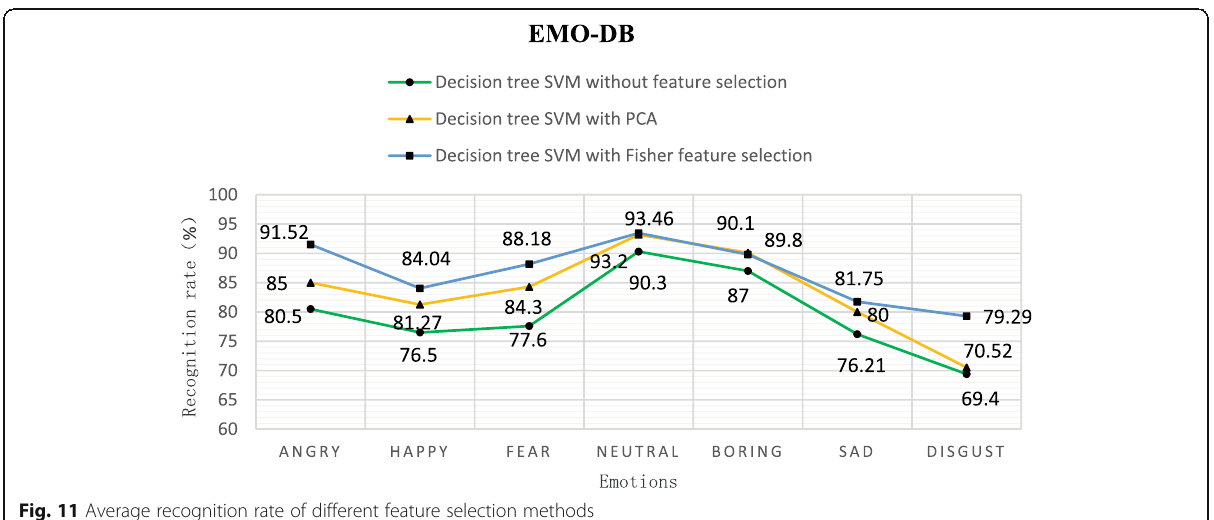
Fig. 11 Average recognition rate of different feature selection